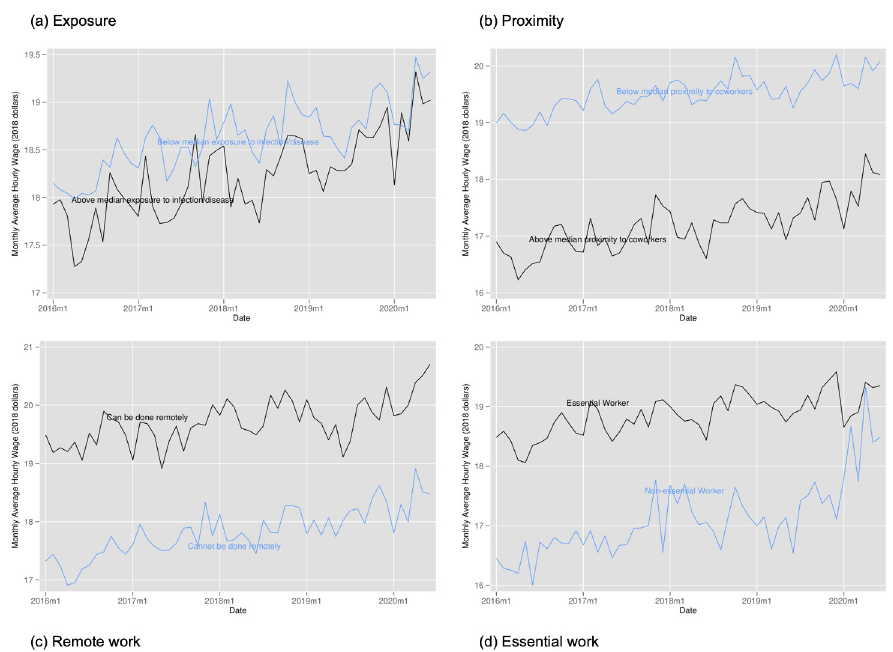
Fig 9. Hourly wages by exposure to disease, proximity to coworkers, remote work, and essential work. Notes: Authors’ calculations. Data from the Current Population Survey. The time period is January 2016 to June 2020. Each panel plots the monthly average hourly wage. Panel A for individuals in occupations above and below the median for our index of exposure to the disease. Panel B for individuals in occupations above and below the median for our index of proximity to coworkers. Panel C for individuals in occupations designated by [1] as being able to be done remotely. Panel D for individuals in occupations designated as essential and non-essential by the Labor Market Information Institute. Hourly wages: civilians aged 16–70 currently employed as wage/salary workers, paid hourly, and were in outgoing rotation groups. Excludes self-employed persons. Trimmed to exclude values below 1st percentile and above 99th percentile. Reported in 2018 constant